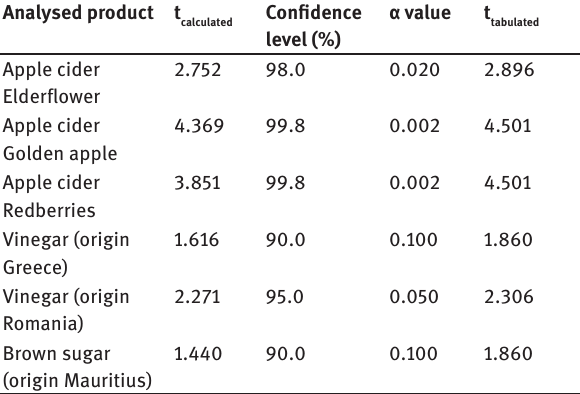
Table 2: The results of the t-test performed on the concentration values furnished by voltammetry and